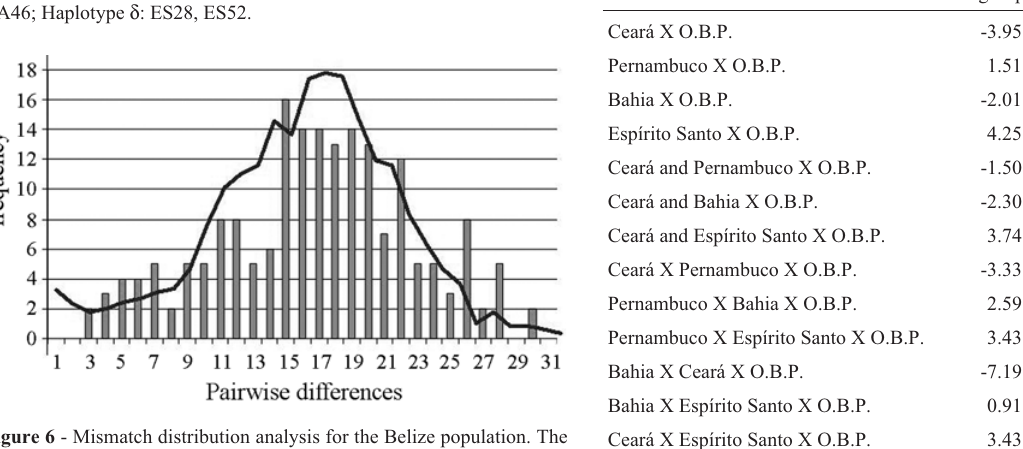
Figure 5 - mtDNA control-region haplotype network. Different shades of grey are used to indicate sample locations. Hypothetical non-sampled haplotypes are indicated by dots. Lines connecting haplotypes correspond to single nucleotide changes. Dotted line surrounds haplotype clusters from the southwestern Atlantic. Haplotype α : samples CE22, CE06, PE01,PE06,PE10,PE13,PE14,PE17,BA10,BA11,BA47,ES04,ES07, ES41, BE62; Haplotype β : CE05, CE53, PE4, ES42; Haplotype γ : BA43, BA46; Haplotype δ : ES28, ES52.